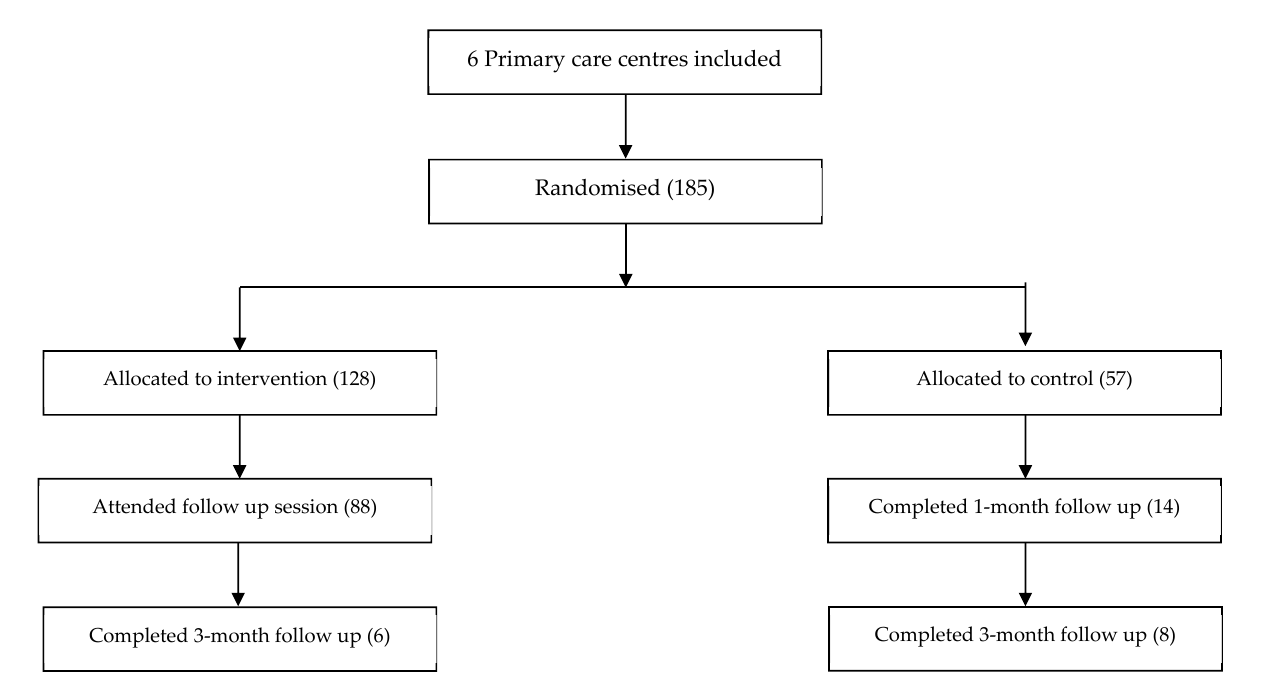
Figure 3. Flow diagram of the primary care centres recruitment and follow-up process.